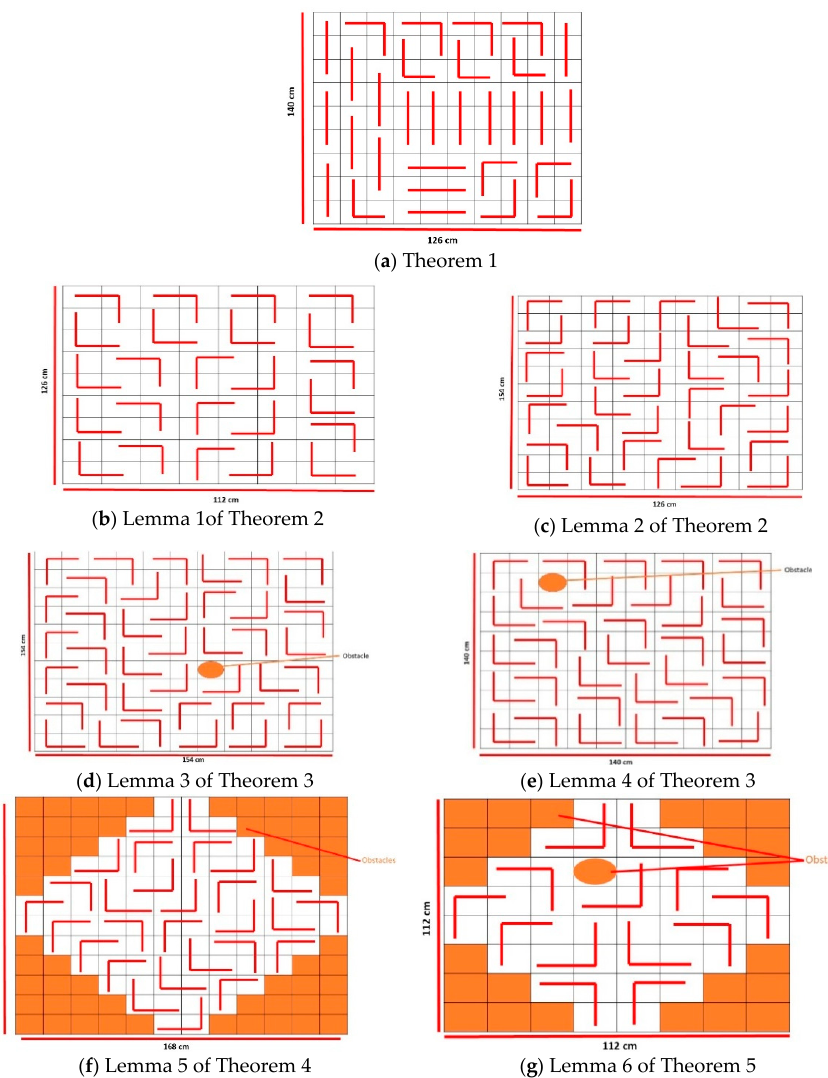
Figure 13. Tiled Testing Area with I- and L- trominoes.